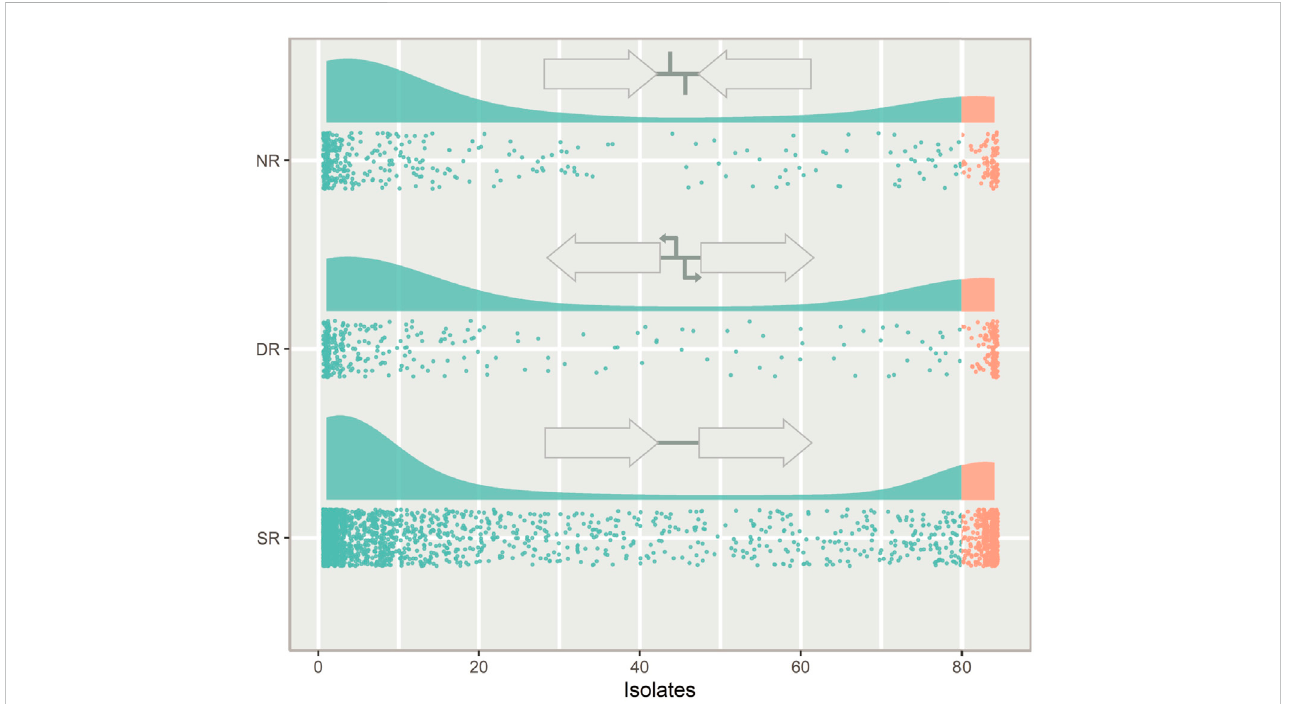
FIGURE 3 Thetypesofintergenicregions(IGRs)andtheirdistributioninthepneumococcalpangenome, illustratedwitharaincloudplot.EachpointisauniqueIGR of that type plotted against the number of isolates in the pangenome it is present in. Cloud areas are scaled relative to the size of each dataset. Core IGRs are present in > 95% strains (orange) and accessory IGRs are present in < 95% of isolates (green). The IGRs are categorized according to the orientation of their fl anking genes. If the fl anking genes are pointing in the same direction the IGR is categorized as single regulatory (SR), if they face towards the IGR, it is categorized as non-regulatory (NR) and if they face away from the IGR, it is categorized as double regulatory (DR).